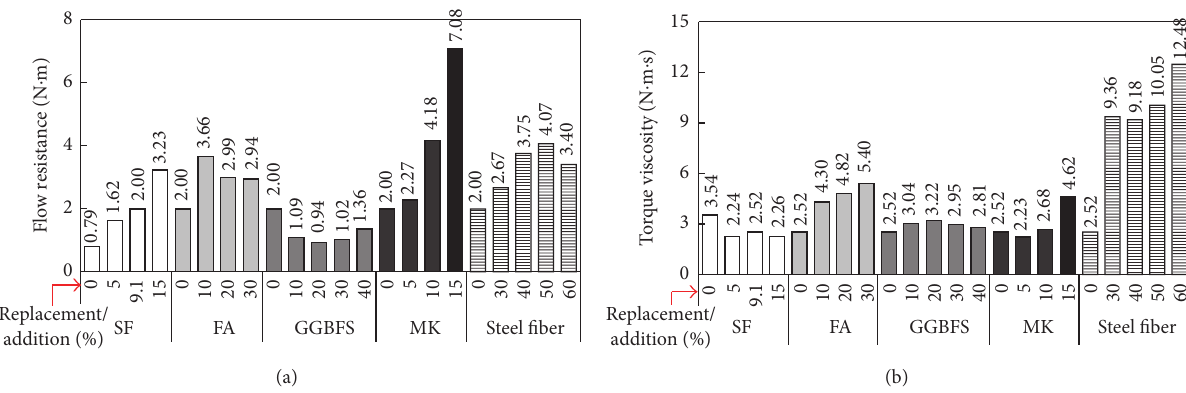
Figure 10: Variations in rheological properties for various WMS mixtures: (a) variations in flow resistance and (b) variations in torque viscosity.